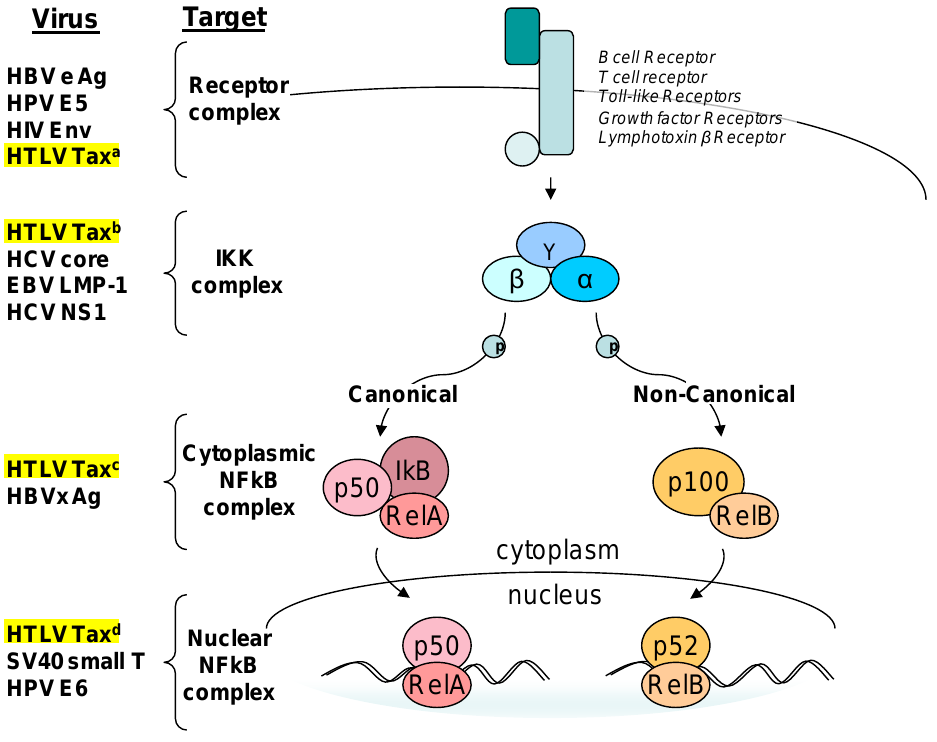
Figure 2. Tax targets the NFκB pathway. A simplified schematic of NFκB signaling pathways highlighting regulatory proteins commonly targeted by viruses